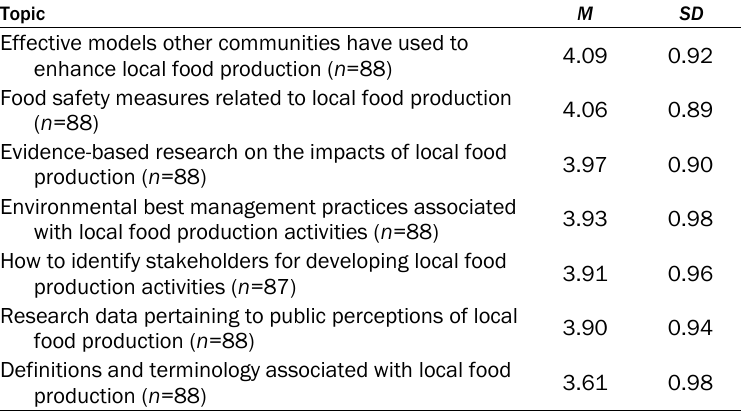
Table 8. Usefulness of Informational and Training